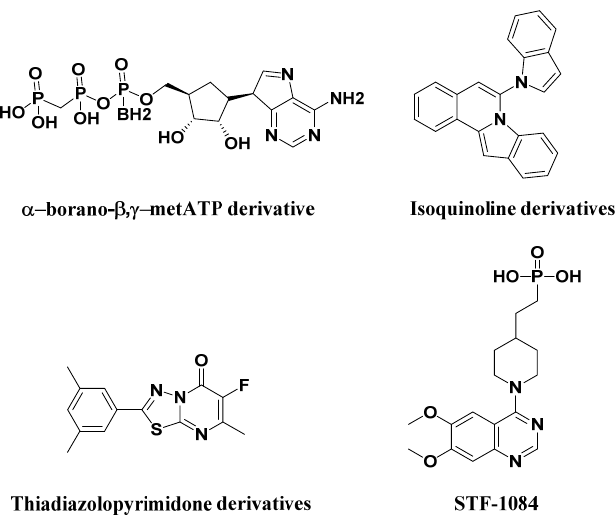
Figure 2. Structures of known ENPP1 inhibitors.